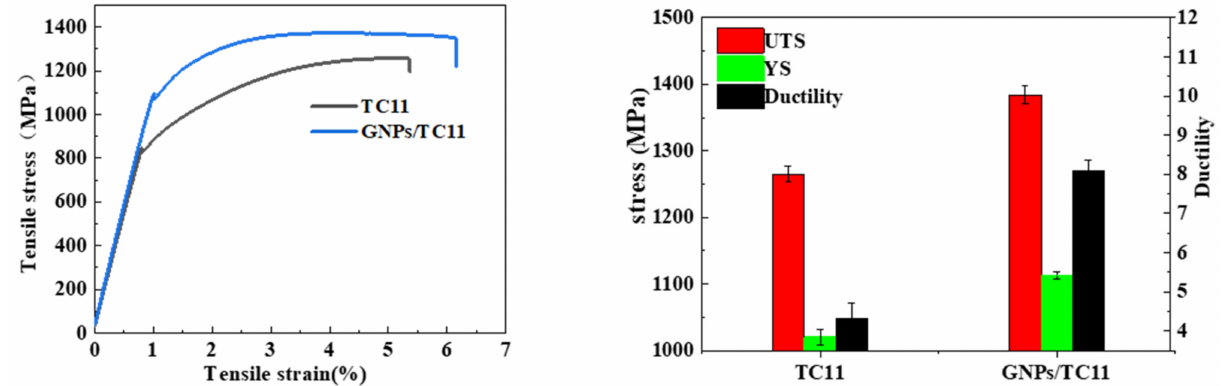
Figure 9. Stress–strain curves and tensile properties diagram of TC11 titanium alloy and GNPs/TC11 composite samples.